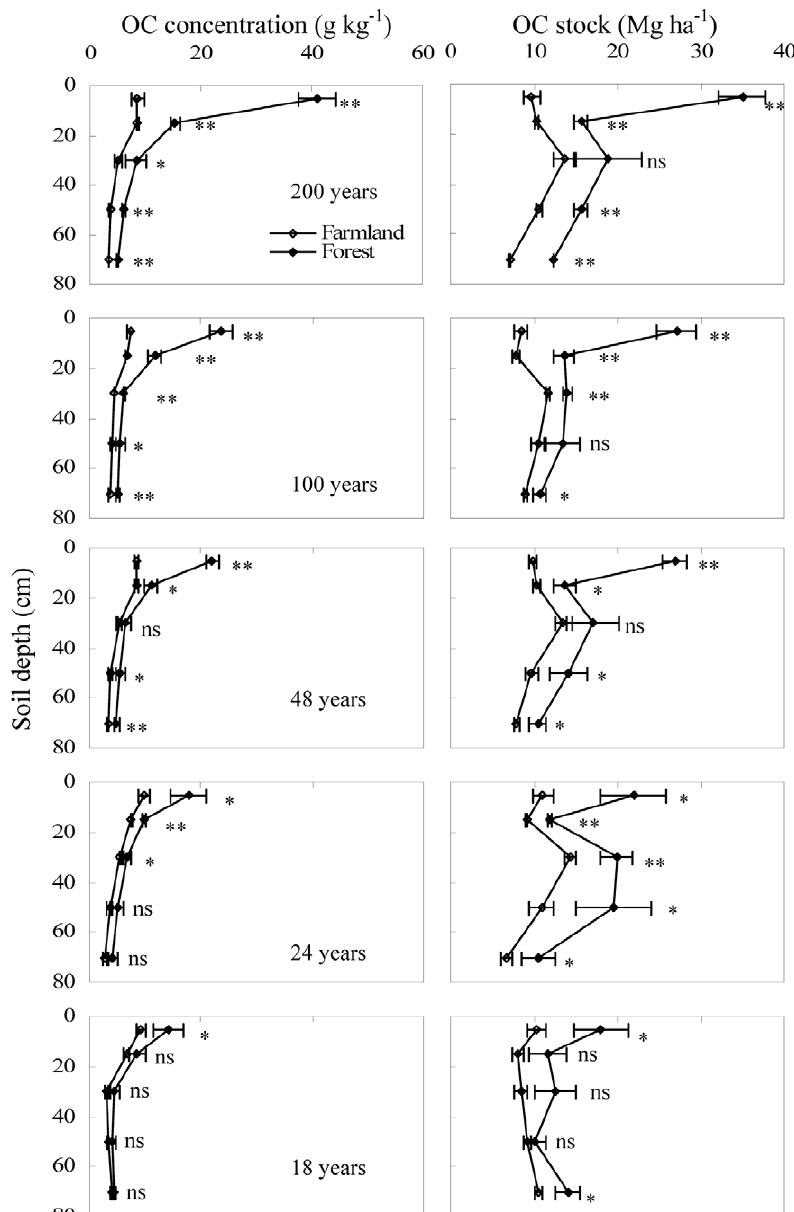
Figure 2. Effects of afforestation of abandoned farmland on soil OC concentration and stock at different stand ages (*: the difference between forest and farmland was significant at P , 0.05; **: the difference was significant at P , 0.01; ns: P . 0.05; the error bars are standard deviation of the means).